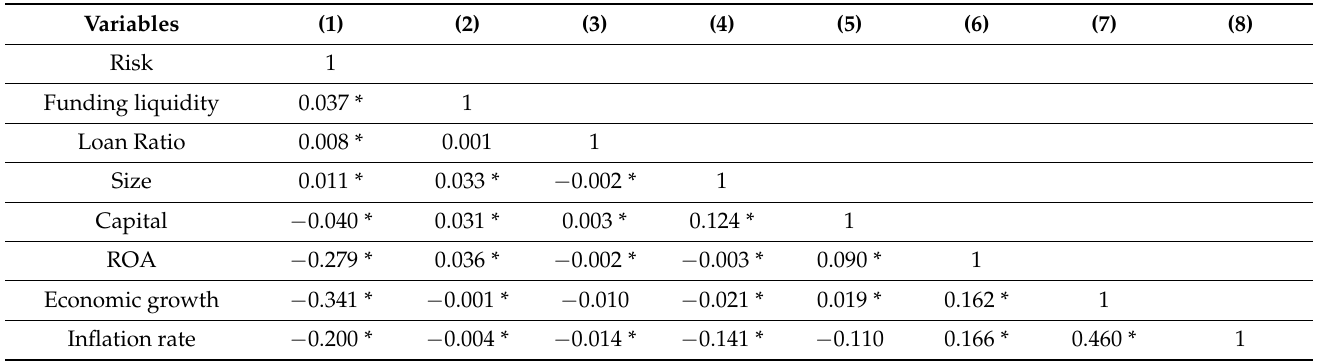
Table 2. Matrix of correlations.